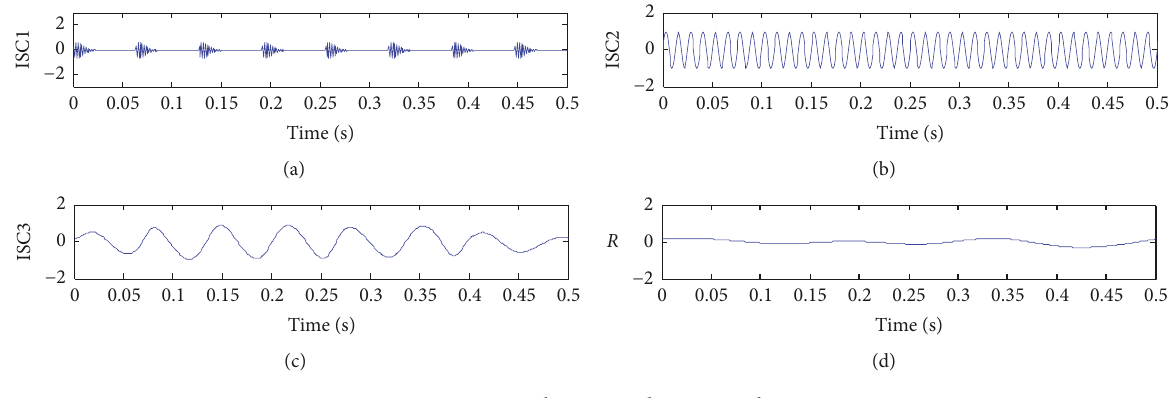
Figure 4: Simulation signal ELCD